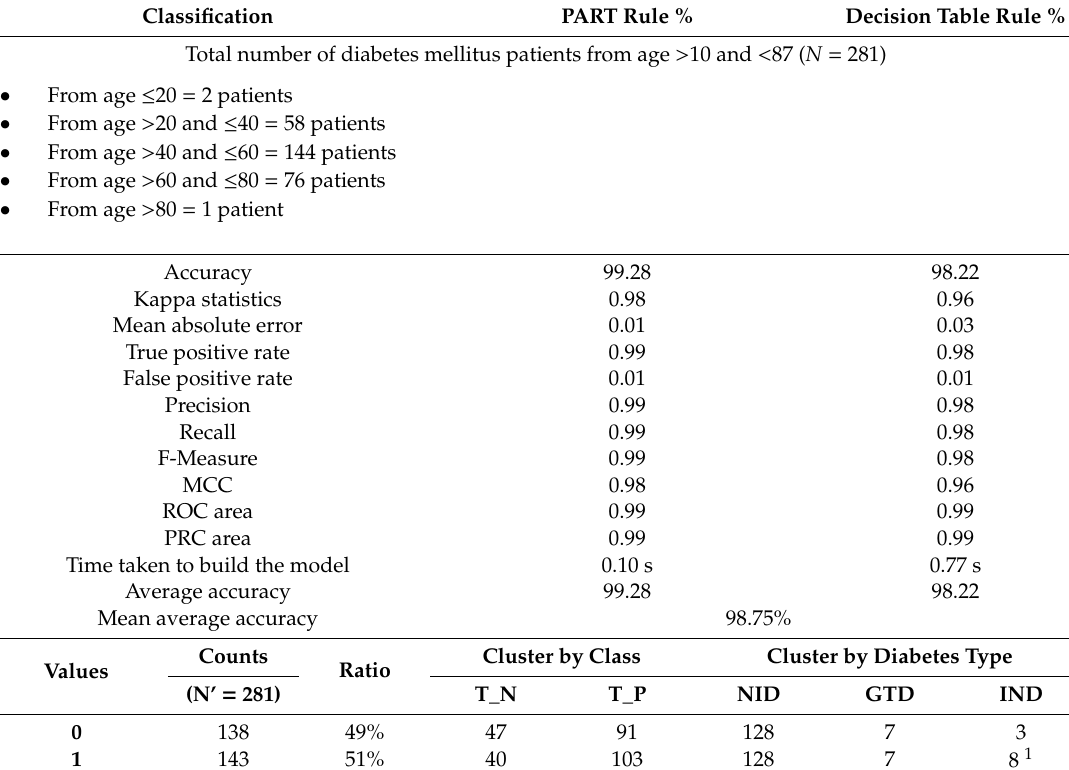
correlation curve; ROC = Receiver operating characteristics; PRC = Precision recall curve; N = number of patients; ≥ greater than; ≤ less than; % = percentage value; T_N = tested negative; T_P = tested positive; Values = two clusters 0 and 1; N´ = total number of classified